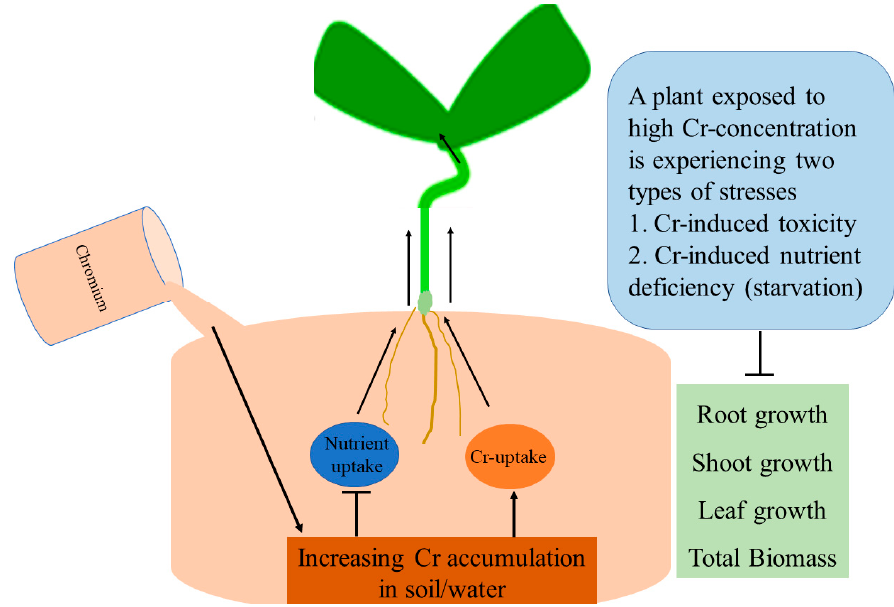
Figure 2. Functional model for the Cr-induced nutrient uptake inhibition and plant growth retardation. Increasing concentration of Cr in soil/water compete with the nutrients uptake that is leading in the increasing Cr accumulation in plant and reduction of nutrients. So, in the presence of high Cr concentration plant faces two stress simultaneously: 1. High Cr accumulation-mediated phytotoxicity. 2. Nutrient deficiency-mediated metabolic abnormality.